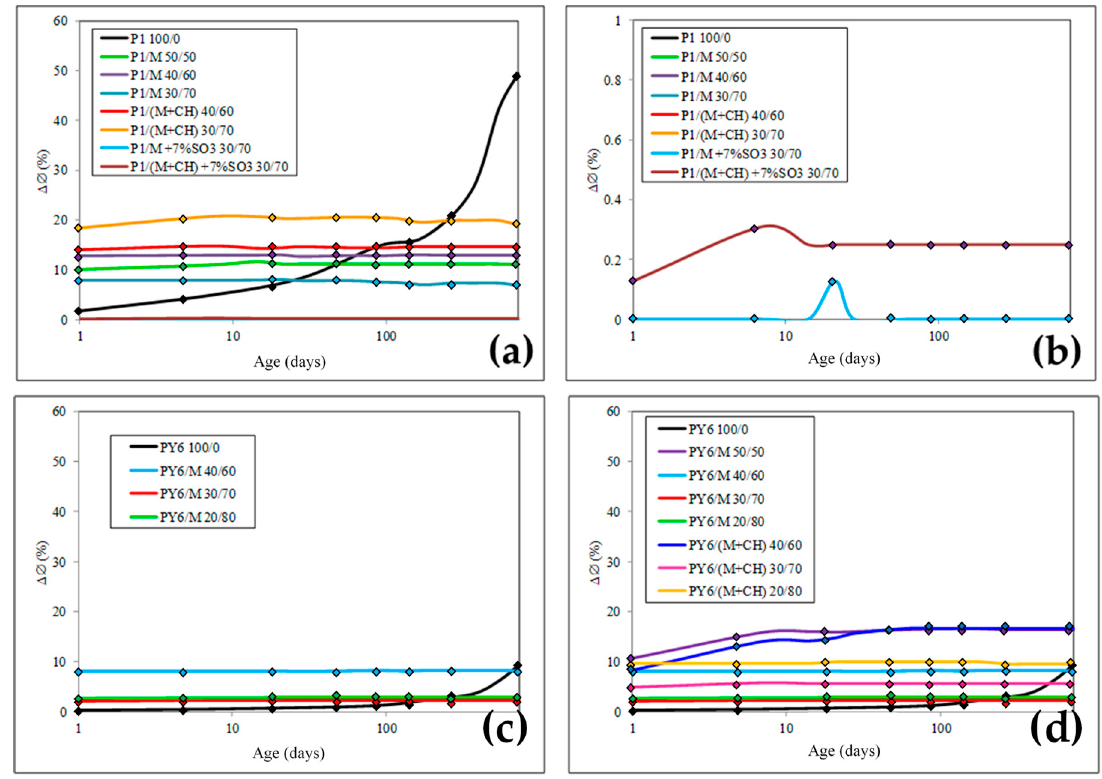
Figure 3. L–A specimens: increase in diameter, ∆ Ø (%), versus age. ( a , b ) P1 and their M blended cements, ( c , d ) PY6 and their M blended cements.